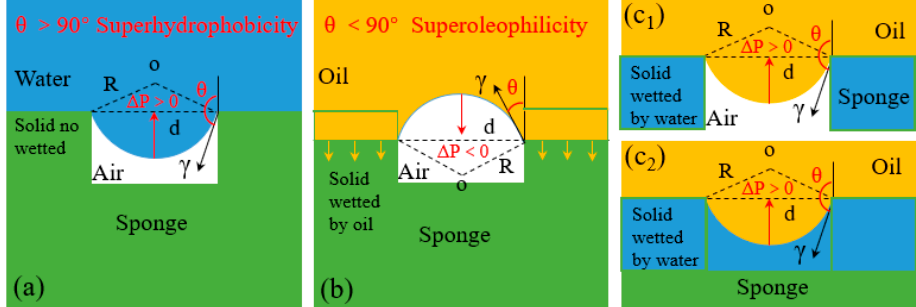
Figure 7. Schematic illustration of liquid ‐ wetting modes of 3D materials [74,89,90]; ( a ) because Δ p is positive, the superhydrophobic 3D material repels the water penetration by the trapped air. ( b ) because Δ p is negative, the oil can permeate the superhydrophobic 3D material spontaneously. ( c ) there are two states of the oil supported by superhydrophilic 3D materials: ( c 1 ) the oil layer supported by the trapped air in cavities, ( c 2 ) the oil layer supported by the trapped water in cavities; reproduced with permission from the Royal Society of Chemistry.